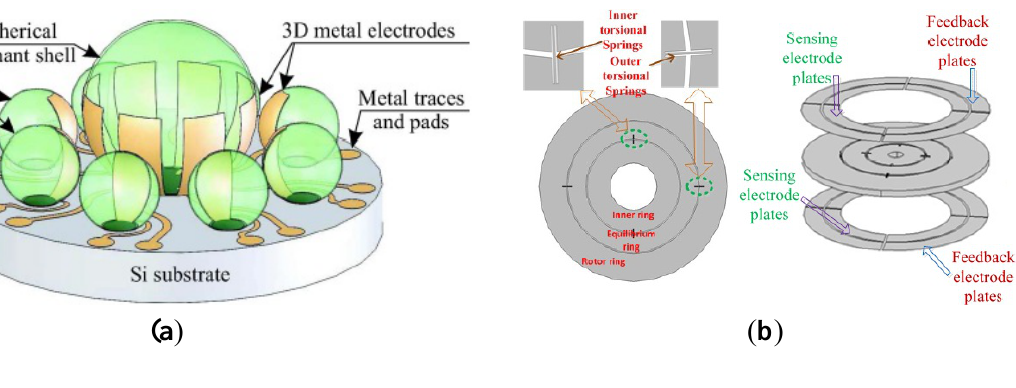
Figure 25. ( a ) 3D spherical shell resonator. ( b ) Southeast University